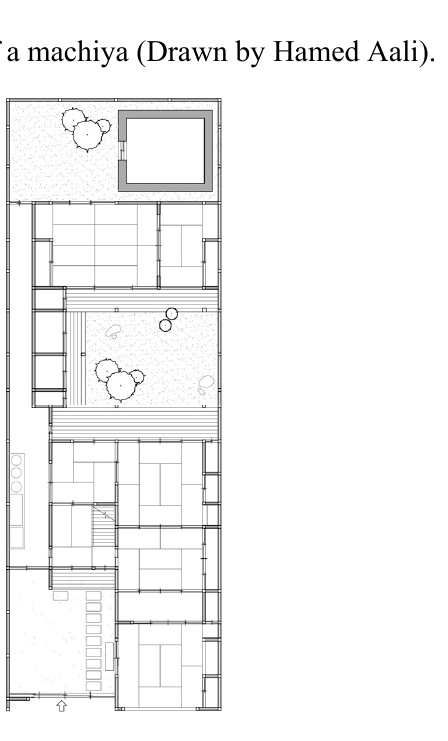
Figure 5. Analysis of cross-ventilation in machiya (Drawn by Hamed Aali and Jiwhan